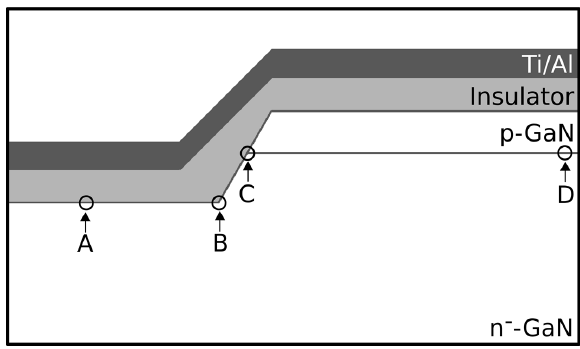
Figure 4. Enlarged view of the mesa and the p-n junction. Point A is the bottom face of the mesa. Point B is